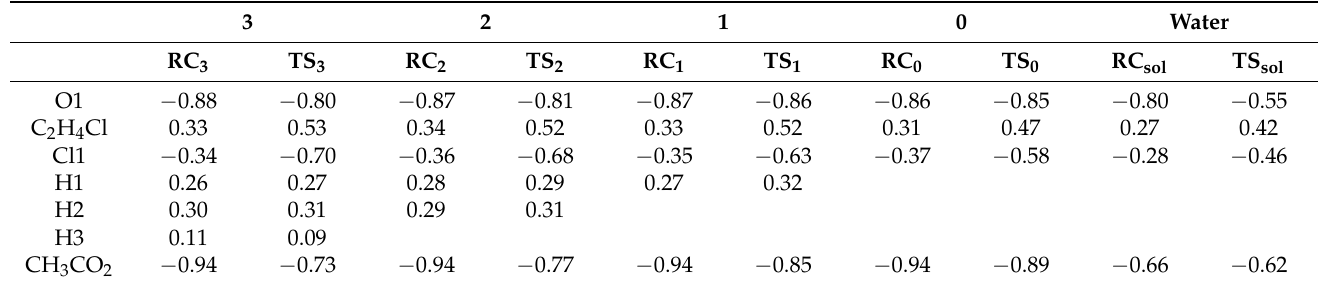
Table 1. The charge distributions of the key atoms or groups of the reactant complexes (RC), transition states (TS) for the AcO − + DCE reaction in the presence of three, two, one and zero residues, as well as the reaction in water solution. (The detailed charge distributions of the RC, TS and product complexes are listed in Table S1 of the Supplementary